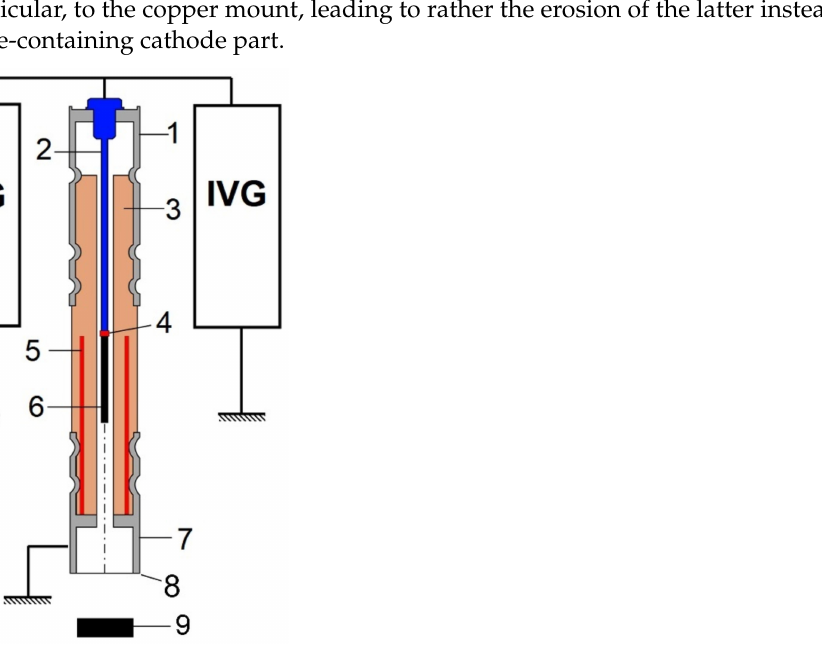
Figure 1. The principal scheme of EAPA and its electrical installation: 1, 7—steel shells,